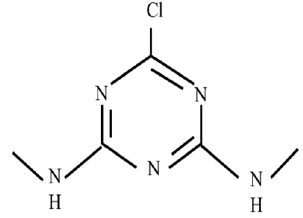
Figure 16. Chemical structure of Simazine. Table 5. Experimental parameters of the prepared samples.